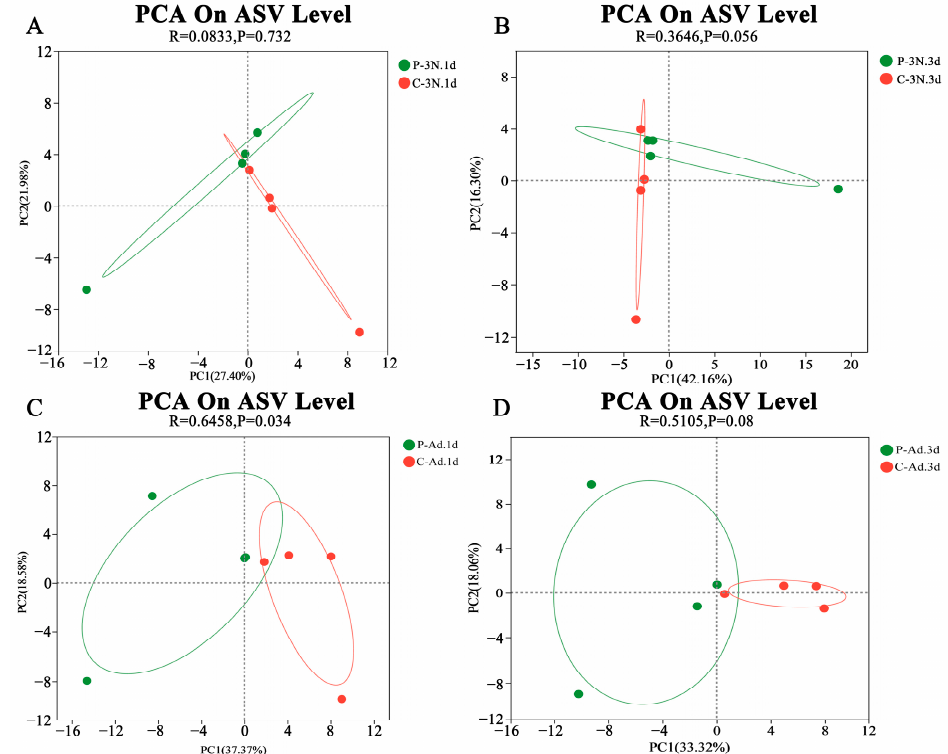
Figure 2. Principal Component Analysis (PCA) based on ANOSIM distances between treatments. ( A , B ) PCA of ovaries of third-instar nymphs that parasitized and unparasitized for 1 d and 3 d, ( C , D ) PCA of ovaries of adults that parasitized and unparasitized for 1 d and 3 d. The treatment groups are abbreviated as follows: C-3N.1 d = ovaries of third-instar nymphs that unparasitized for 1 d, P-3N.1 d = ovaries of third-instar nymphs that were parasitized for 1 d, C-3N.3 d = ovaries of third-instar nymphs that unparasitized for 3 d, P-3N.3 d = ovaries of third-instar nymphs that were parasitized for 3 d, C-Ad.1 d = ovaries of adults that unparasitized for 1 d, P-Ad.1 d = ovaries of adults that were parasitized for 1 d,C-Ad.3 d = ovaries of adults that unparasitized for 3 d, P-Ad.3 d = ovaries of adults that were parasitized for 3 d. ASV means amplicon sequencing variants.